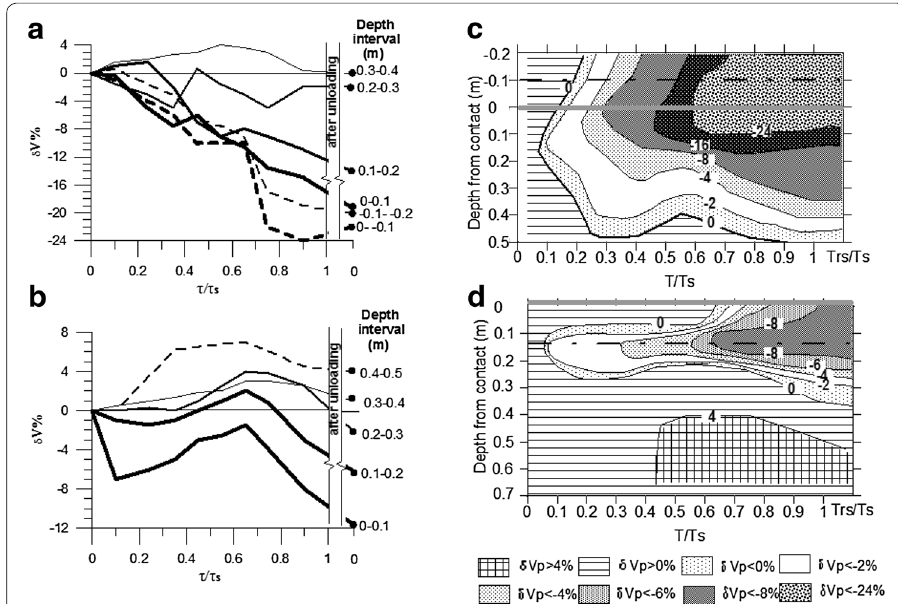
Fig. 9 a Relative interval velocity variations δV% vs relative shear stress τ/τs graphs at the rupture; and b Shear fracture zones; c , d distribution of the δV% in the stamp-rock section at the different loading levels in rupture zone (loaded stamp side) ( c ) and shear one ( d